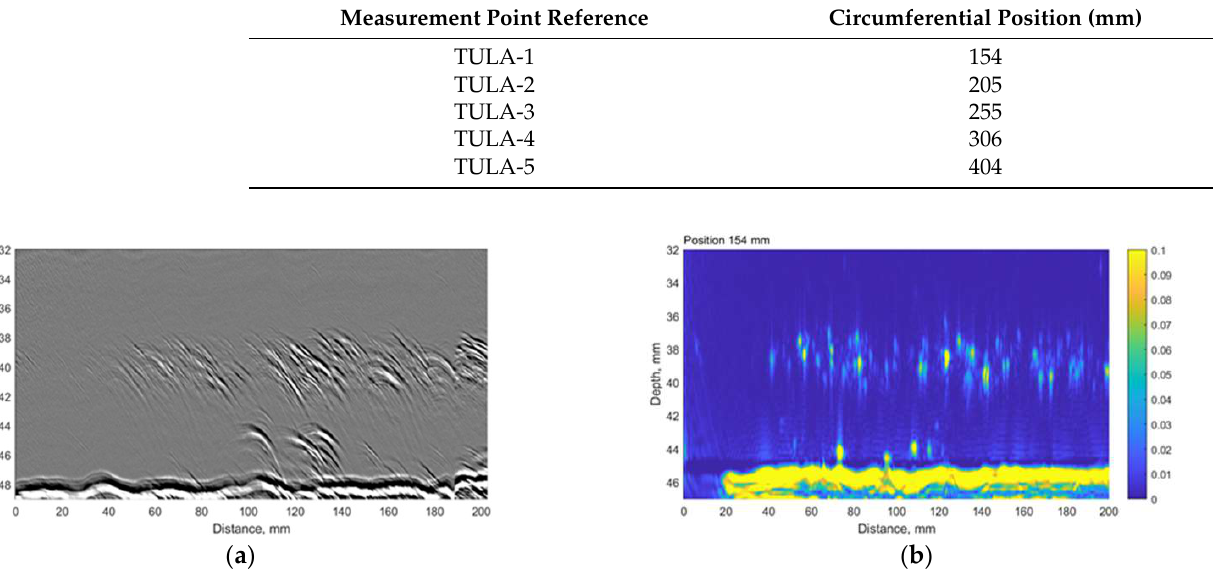
Figure 13. The comparison between ( a ) TULA and ( b ) TFM measurements at 154 mm circumferential scan position. Vertical colour bar represents the peak-to-peak amplitude in arbitrary units.